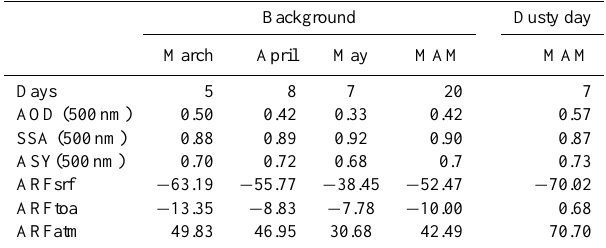
Fig. 4. Difference among observed and calculated broadband (a) total, (b) direct and (c) diffuse radiative flux at the surface on a clean sky (7 April 2009). Table 3. Averaged AOD, SSA, ASY and ARF of background and dusty days in MAM (AOD is retrieved from sky-radiometer di- rectly; SSA and ASY are adjusted values; ARF is calculated by radiative transfer model with retrieved AOD and adjusted SSA and